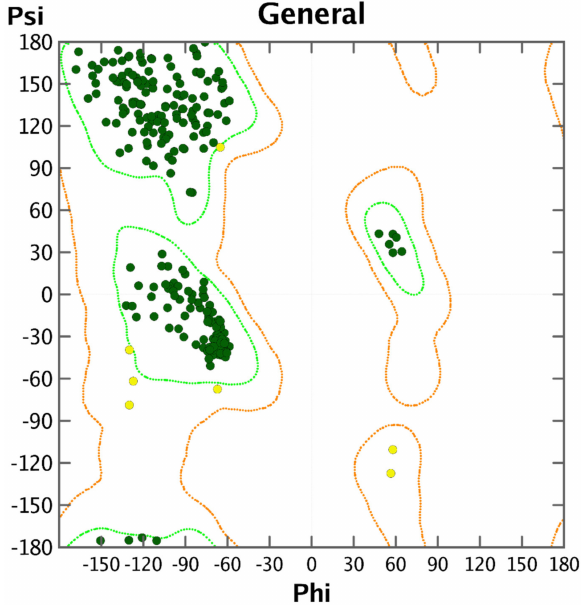
Figure 7. Ramachandran plot for main protease of